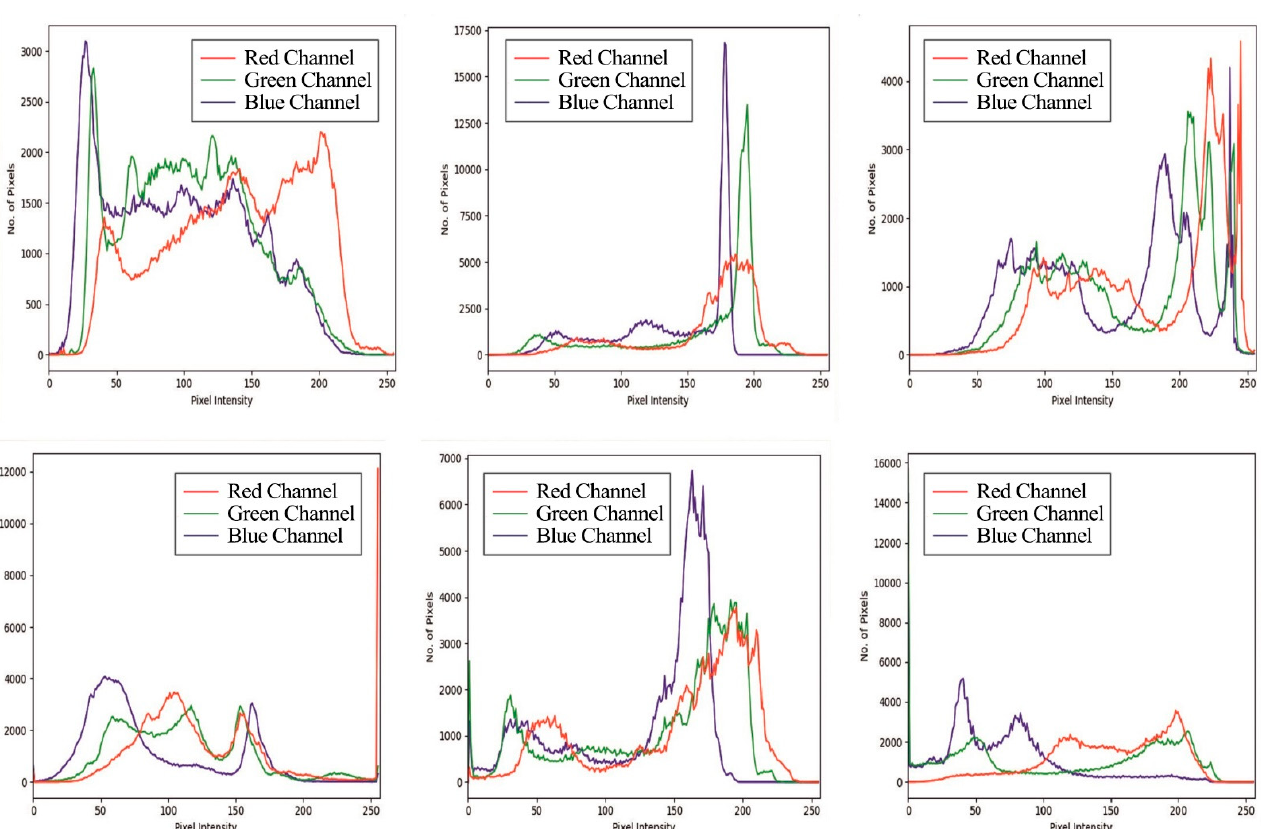
Figure 5. Histogram of Secret Images.